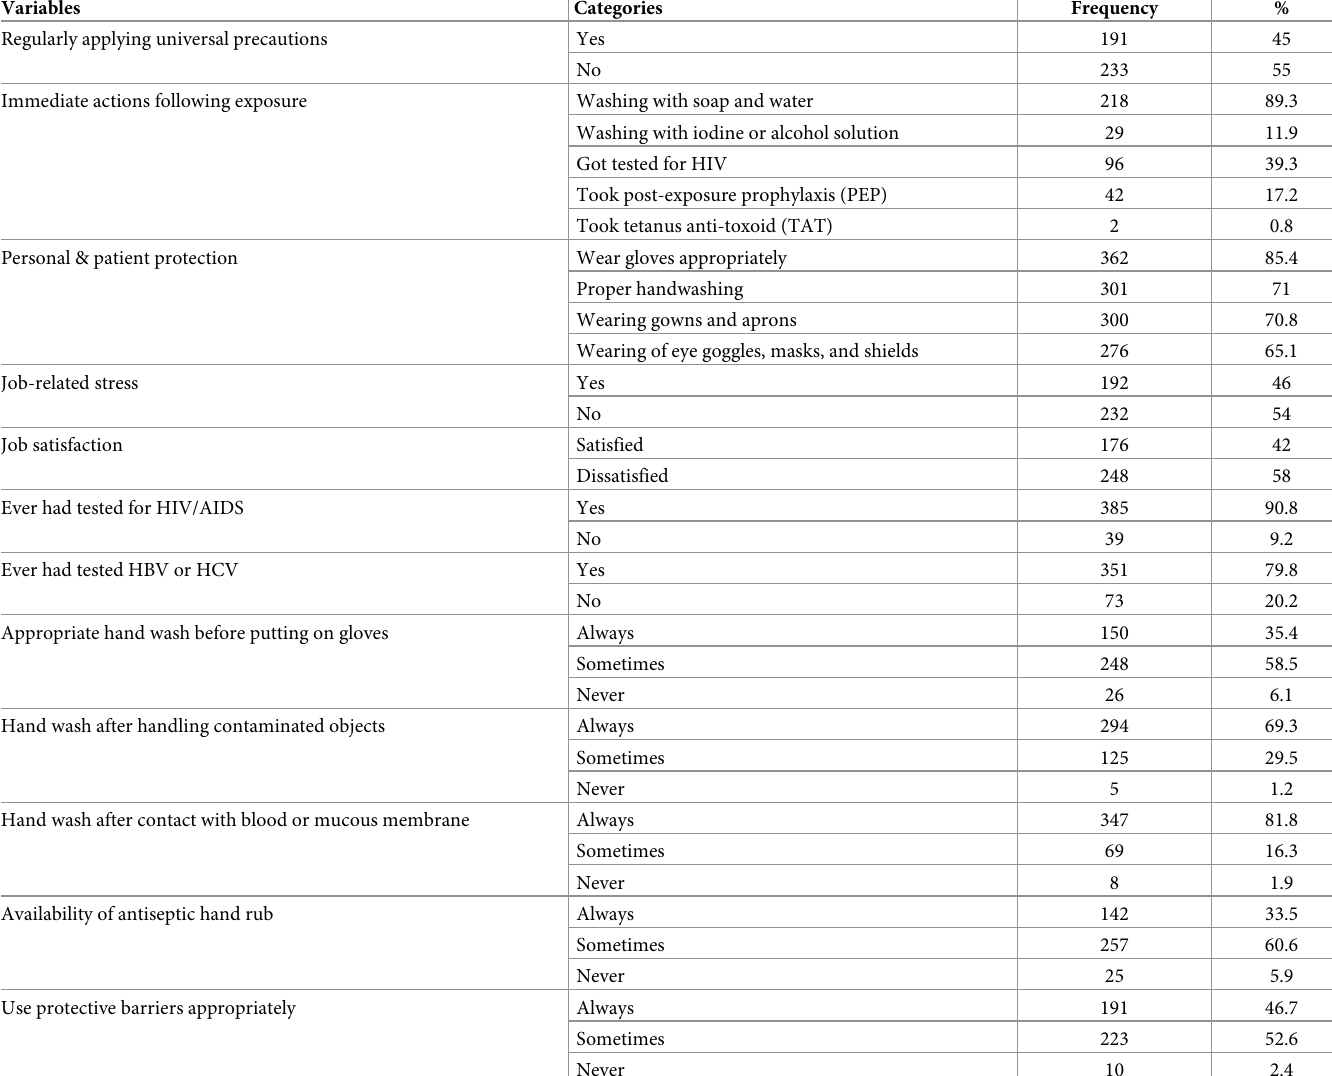
Table 2. Behavior, knowledge, and practice related characteristics of midwives working in public health institutions of Addis Ababa city, Addis Ababa, Ethiopia, 2020.